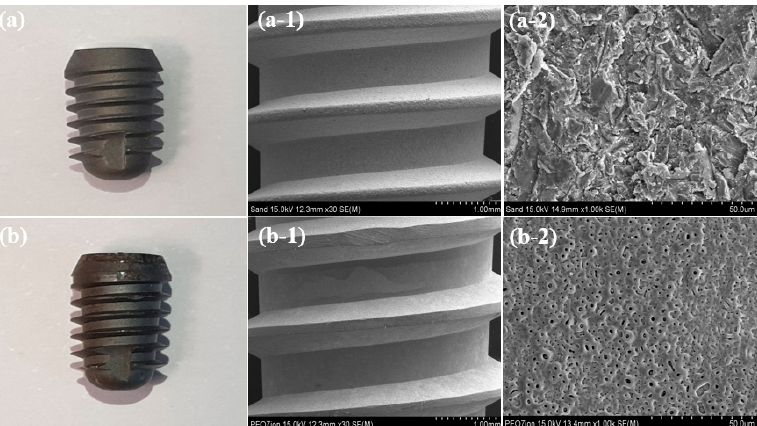
Figure 2. The appearance and SEM images of the Ti-6Al-4V alloy implants treated via ( a , a-1 , a-2 ) sand blasting and ( b , b-1 , b-2 ) plasma electrolytic oxidation (PEO) in a solution containing ions of seven elements.